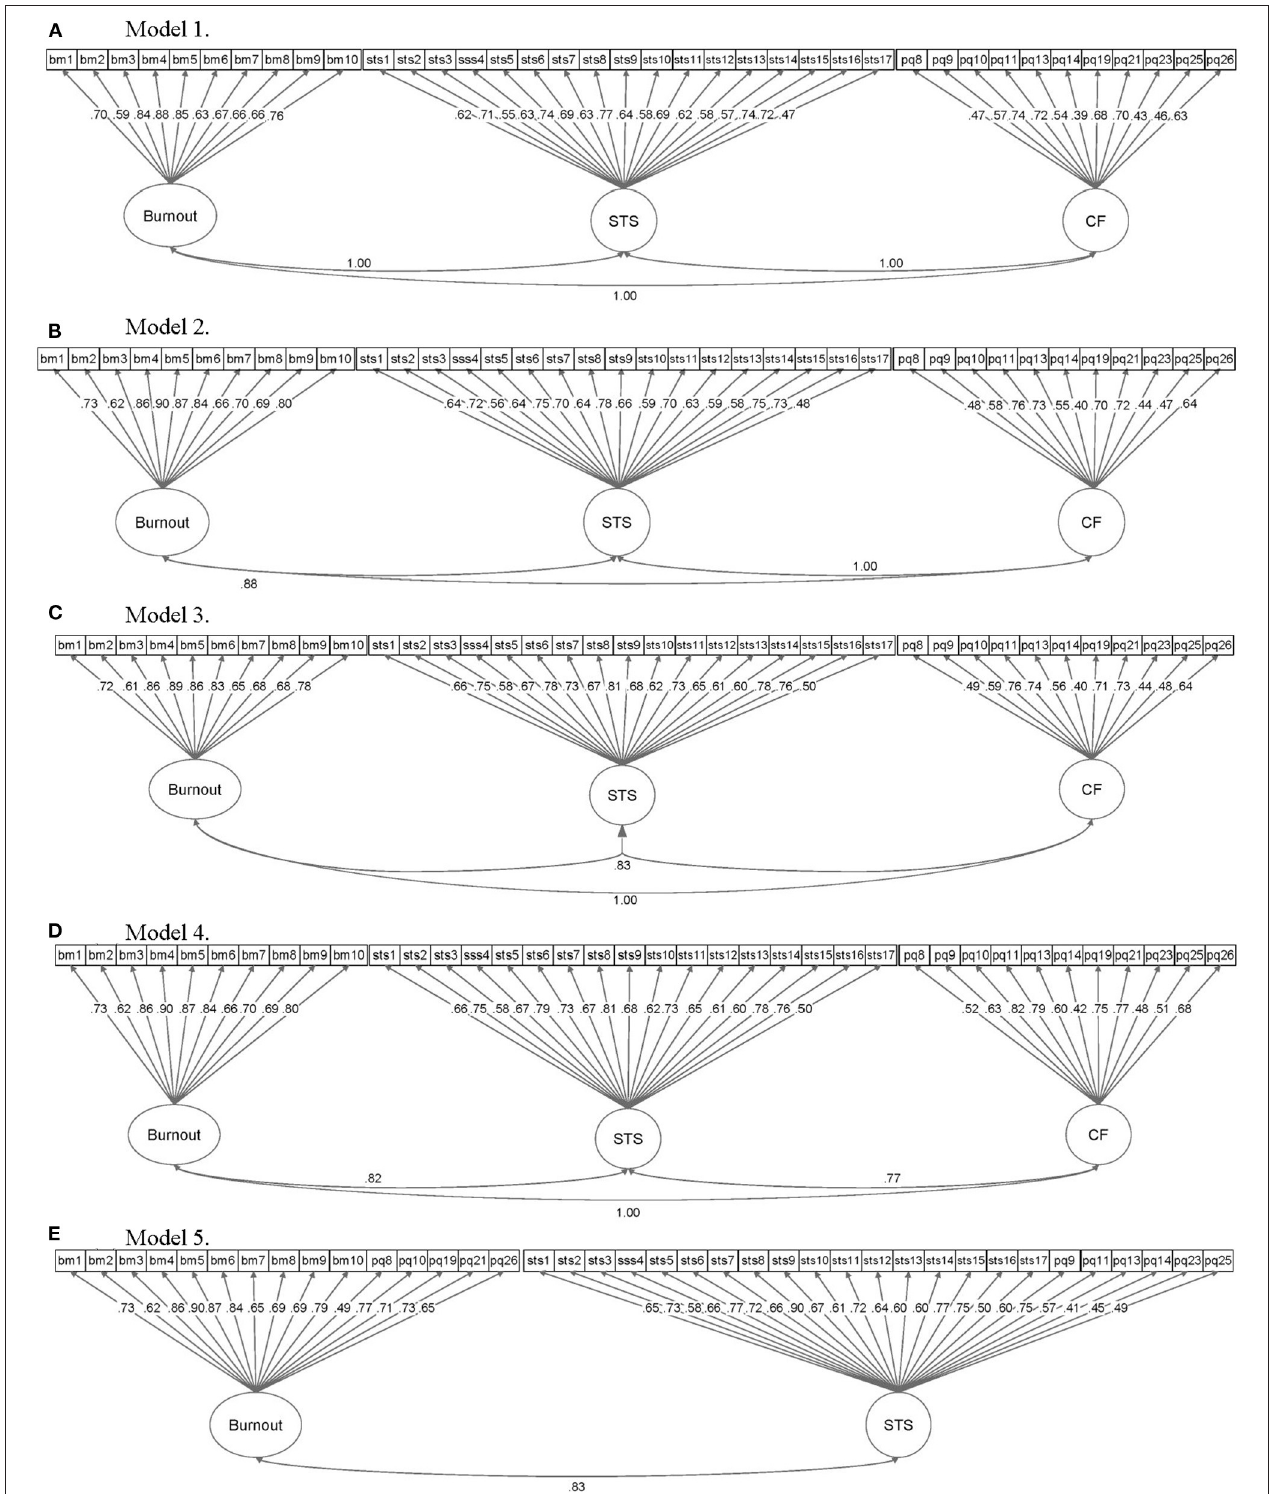
FIGURE 2 | Graphical summary of confirmatory factor analyses results for Models 1–5 of burnout, compassion fatigue, and secondary traumatic stress. Elliptical objects represent latent variables, while rectangular objects represent observed variables (i.e., survey scale items). CF, compassion fatigue; STS, secondary traumatic stress; bm, Burnout Measure-Short Version; pq, ProQOL (although the ProQOL-21 was used, item numbers correspond to original ProQOL item numbers); stss, Secondary Traumatic Stress Scale.